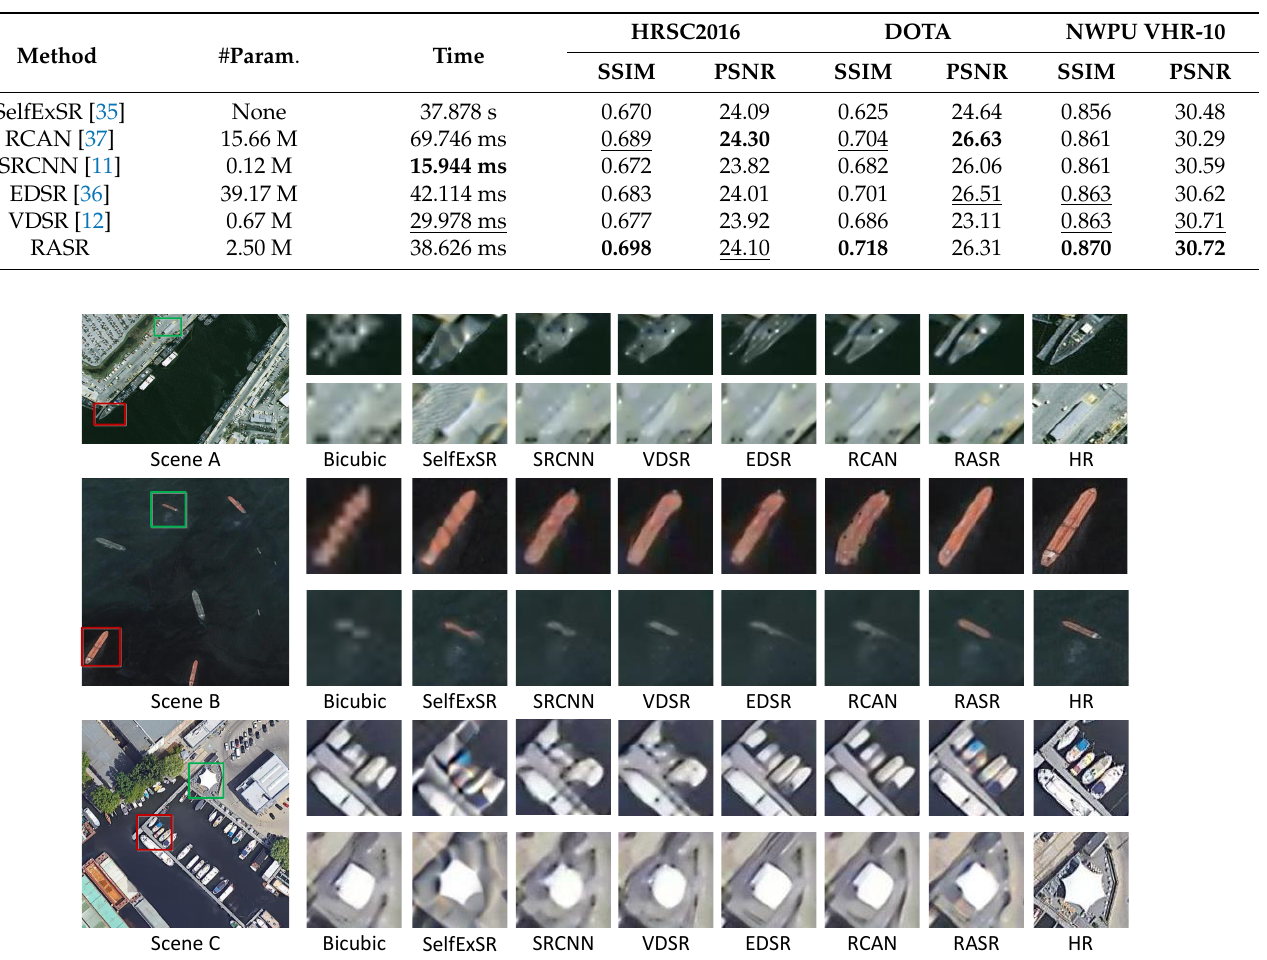
Table 4. Comparisons of the number of parameters (#Param.), SSIM score and PSNR score for different SR methods on HRSC2016, DOTA and NWPU VHR-10 datasets. The best results are in bold faces, and the second results are ubderlined. Note that, the Time is the average processing time per image of each method on the DOTA validation dataset.